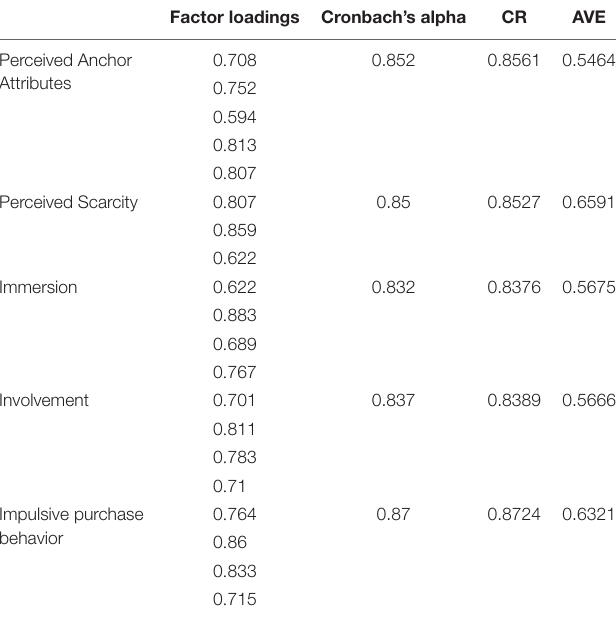
TABLE 4 | Reliability and validity results of measurement